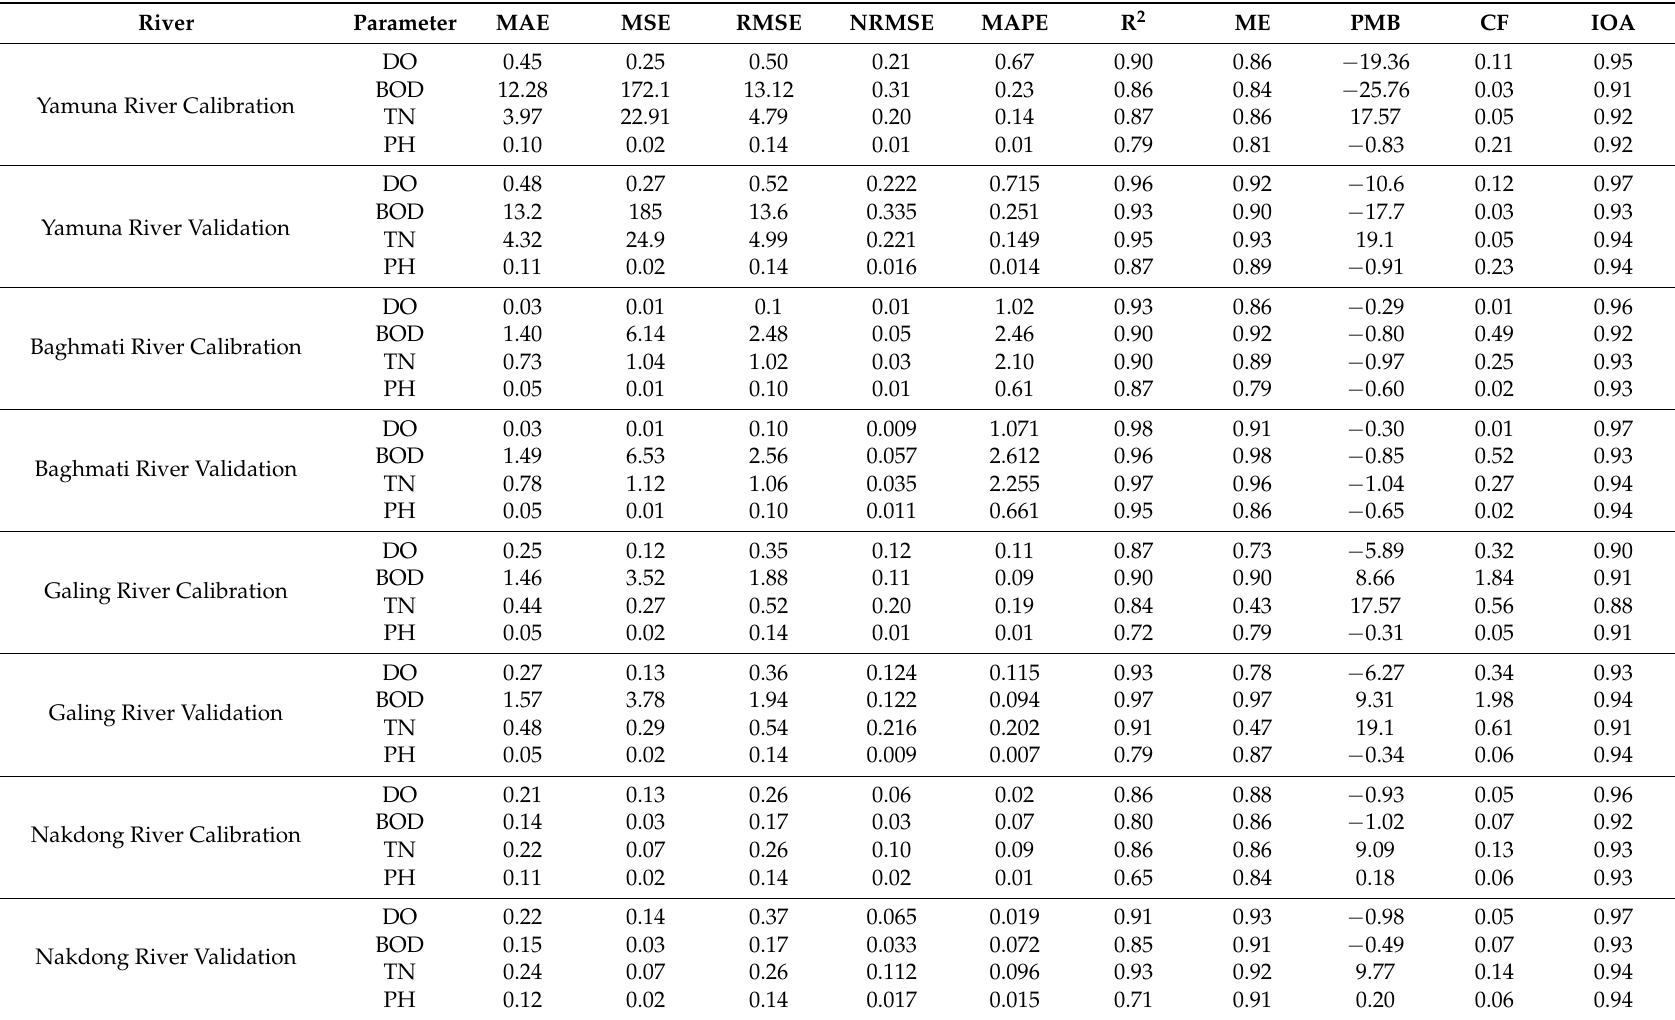
Table 2. Statistical evaluation of calibrated and validated results for predicted and